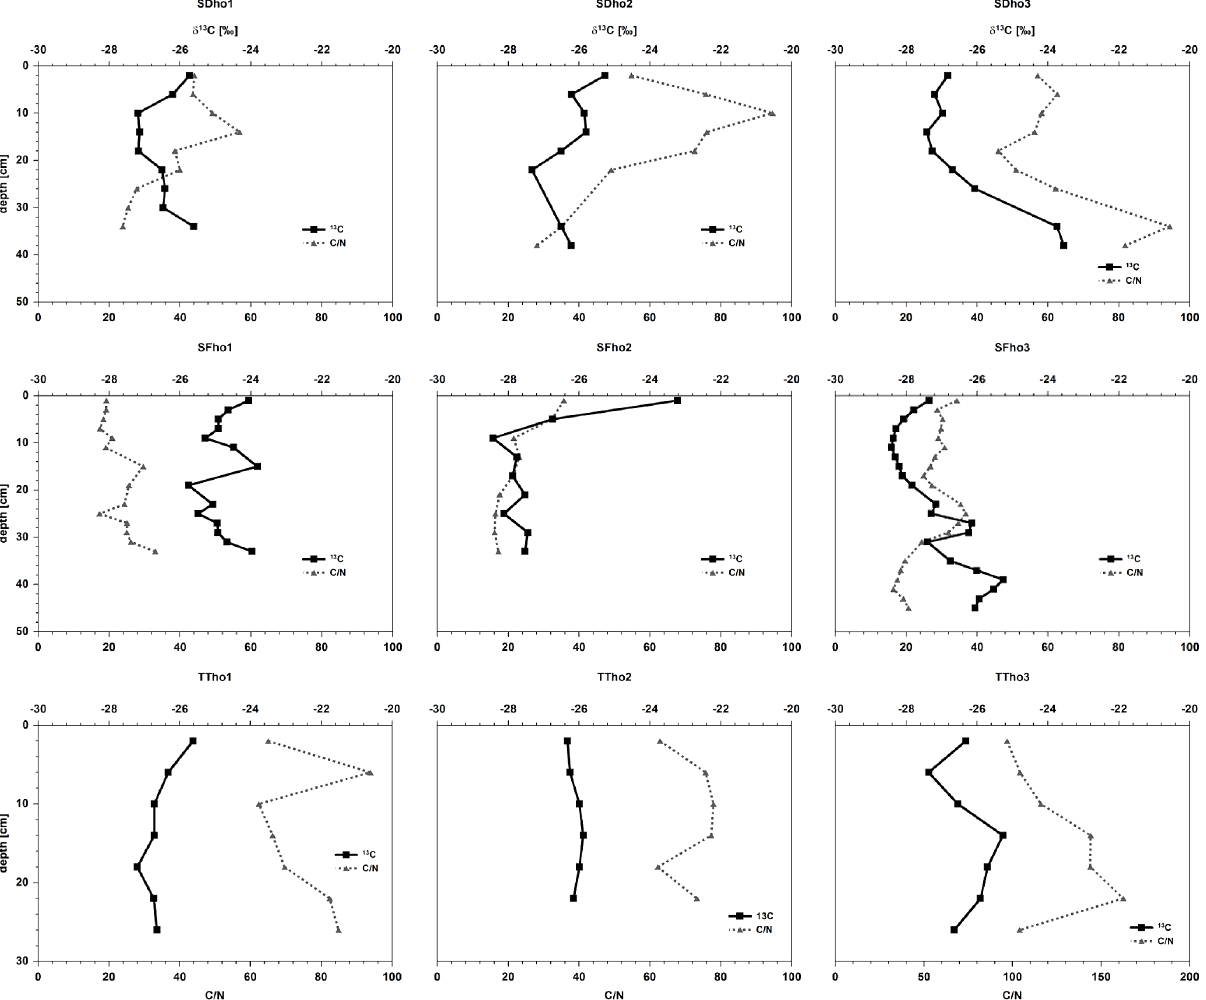
Figure 5. δ 13 C and C/N ratio in depth profiles of hollows (ho) at Stordalen (SD), Storflaket (SF) and Torneträsk (TT)